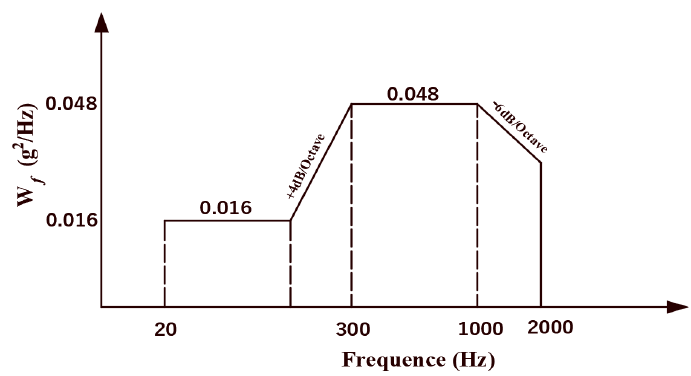
Figure 10. PSD curve of random excitation.